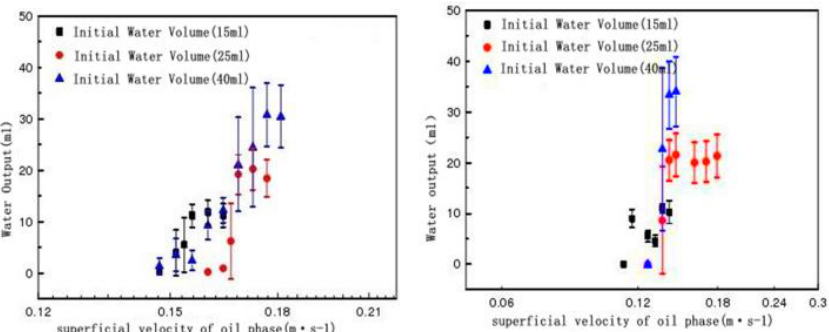
Figure 8. Variation of water output with superficial velocity of oil phase; The left picture represents pipe with the diameter of 27 mm, and the right picture represents the diameter of 41 mm [51]. The left and right sides of Figure 8 show the changes of water output with the oil phase superficial velocity at the same outlet of the upper inclined section with a diameter of 21 mm and 41 mm, respectively. It can be seen from the comparison that under the same oil phase superficial velocity, regardless of the amount of initial water volume, water output decreases with the increase of pipe diameter.